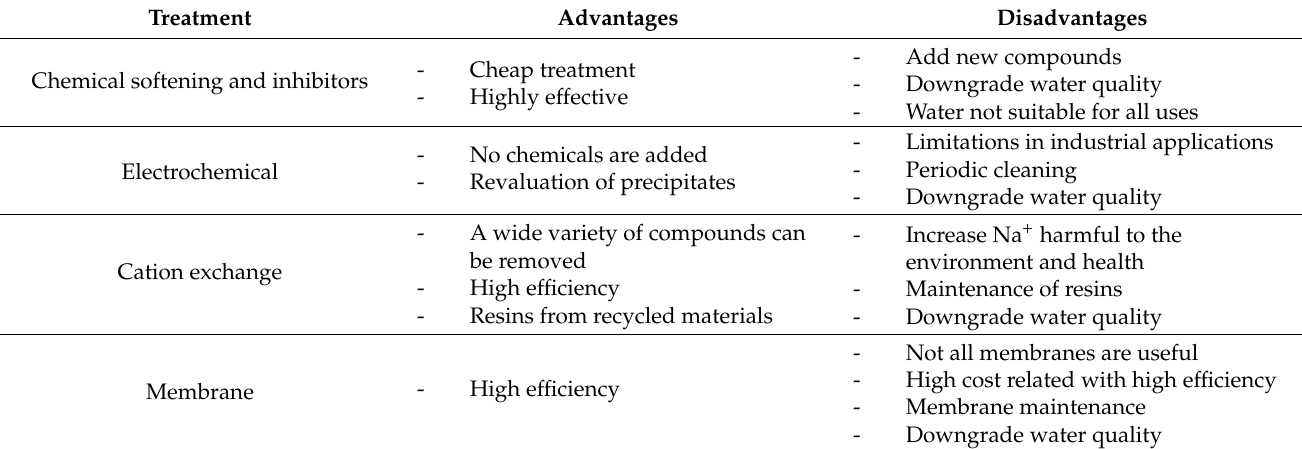
Table 2. Advantages and disadvantages of classical water softening techniques (own elaboration). Treatment Advantages Disadvantages Chemical softening and inhibitors